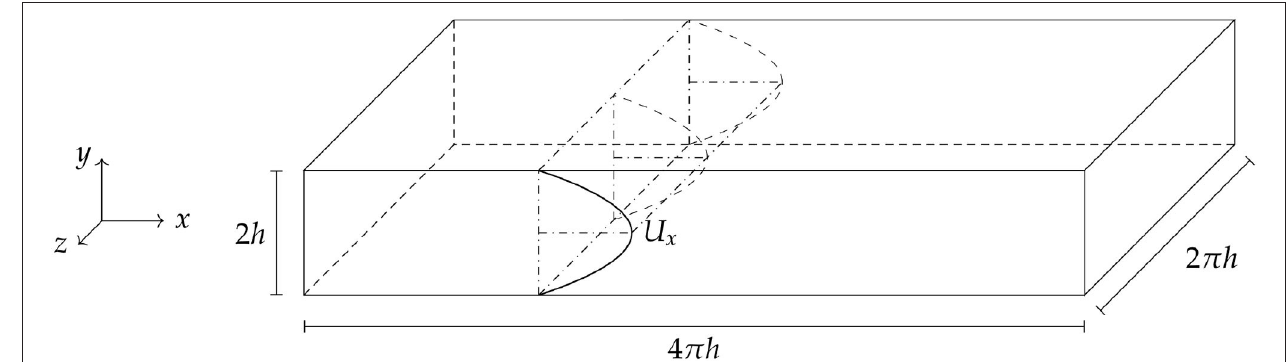
FIGURE 7 | Turbulent channel flow. (A) z -plane sections of the selected windows in the channel. (B) Mean x -velocity and associated xx - covariance component observed from the ground-truth DNS within window 2.